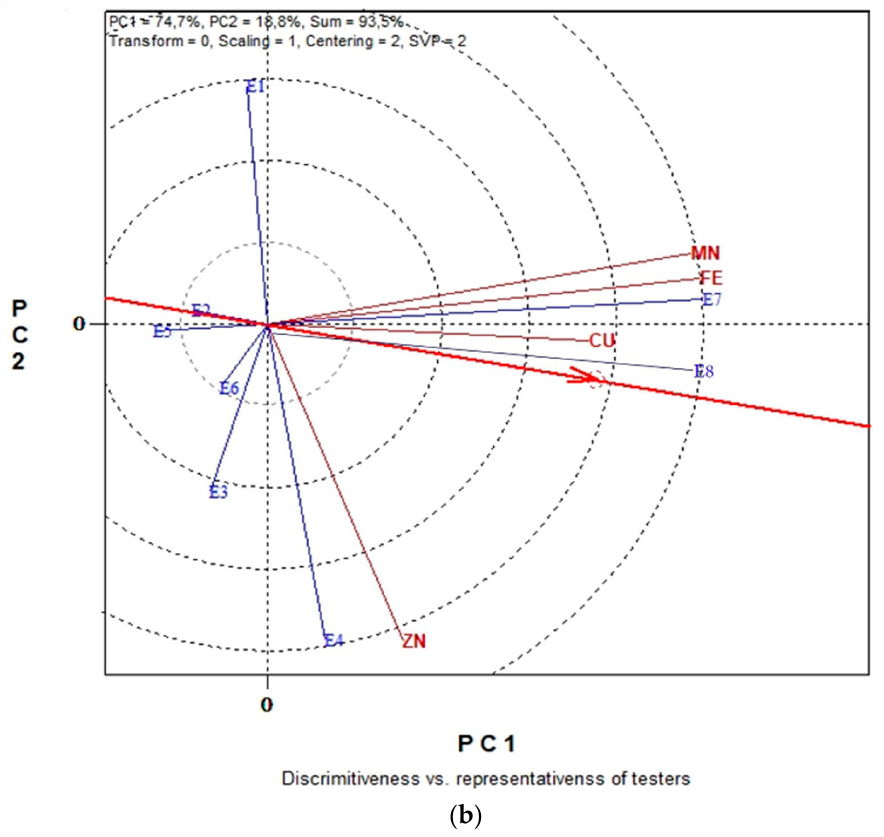
Figure 6. Biplot analysis of seed micronutrient content (Fe, Cu, Mn and Zn) in conventional farming: ( a ) “which-won-where or which is best for what” view of the GGE biplot based on seed micronutrient contents (Fe, Cu, Mn and Zn) of five lentil genotypes in eight environments; ( b ) “discriminating power vs. representativeness” view of the GGE biplot based on seed micronutrient contents (Fe, Cu, Mn and Zn) of five lentil genotypes in eight environments.